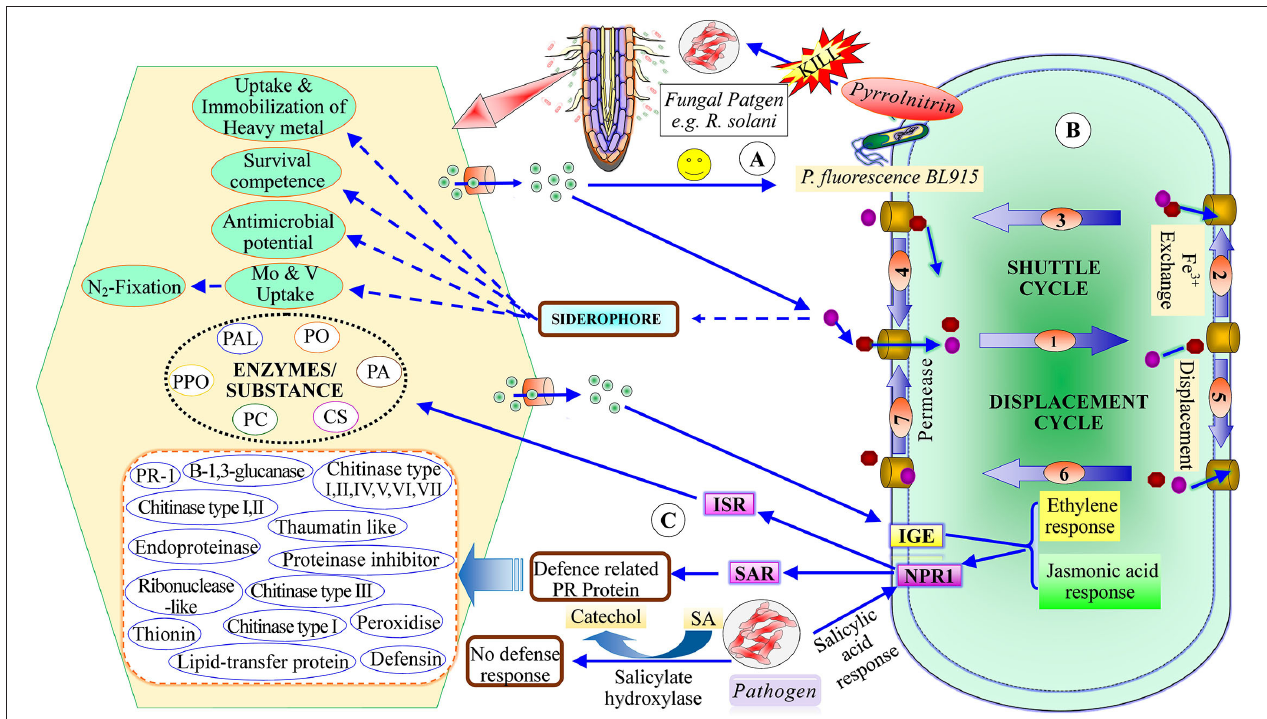
FIGURE 3 | Indirect mechanism of plant growth-promoting rhizobacteria (A) recruited PGPR to produce antibiotic (B) siderophore production and plant growth-promotion, (C) mechanism of induced systematic resistance [ISR, induced systemic resistance; SAR, Systematic acquired resistance; IGE, Induce gene expression; NPRI, Non-expresser pathogenesis-related gene; SA, salicylic acid; PAL, phenylalanine amonislyase; PO, peroxidase; PPO, polyphenol oxidase; PC, poly-phenolic compounds; CS, chalcone synthase; PA,